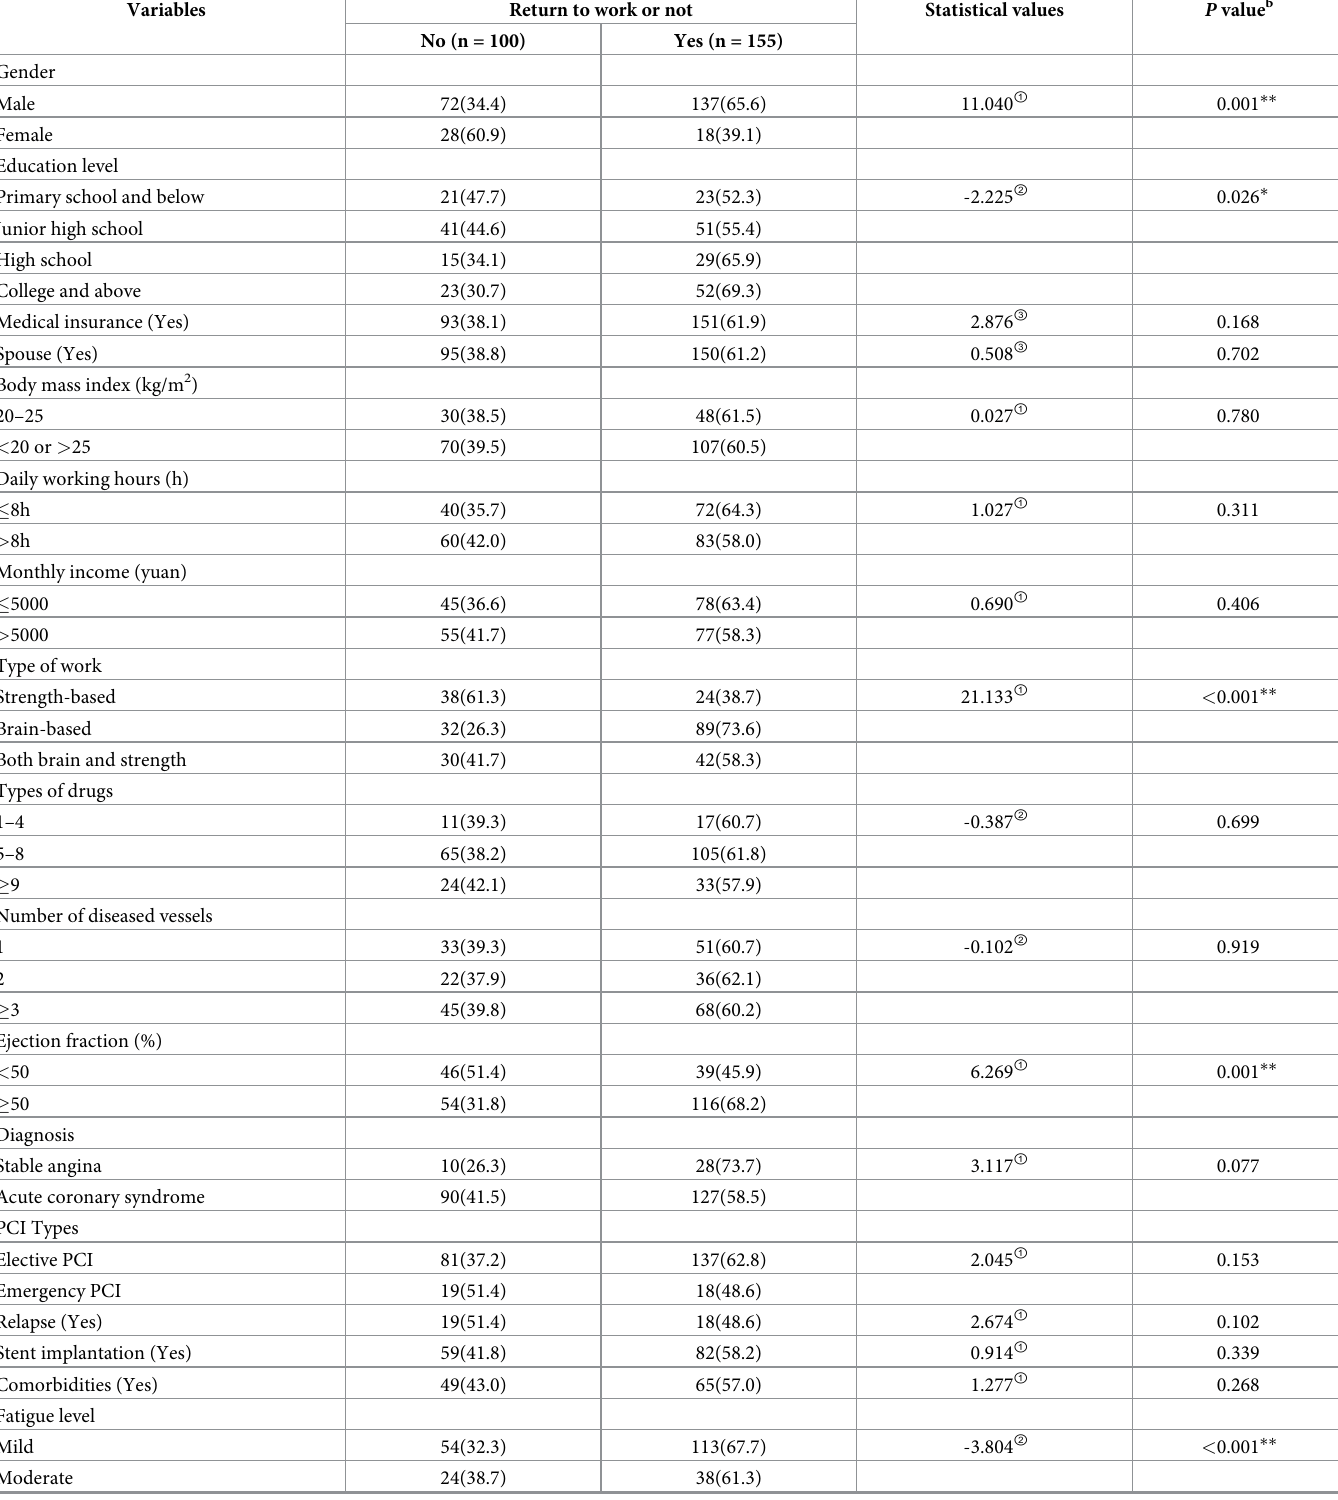
Table 3. A univariate analysis of factors affecting return to work after PCI in young and middle-aged patients with CHD (n = 255).